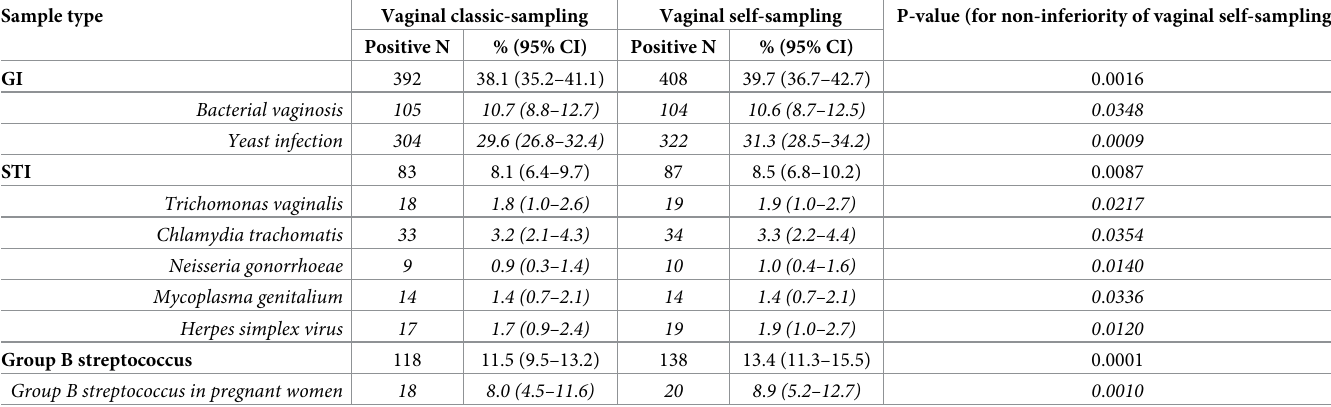
Table 2. Detection rates of GI, STI infection and GBS asymptomatic carriage, and non-inferiority test. Sample